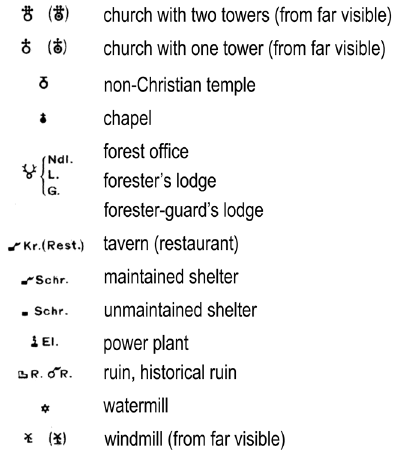
Fig. 6. A part of a legend of a topographic map at the scale of 1:100,000, published by the